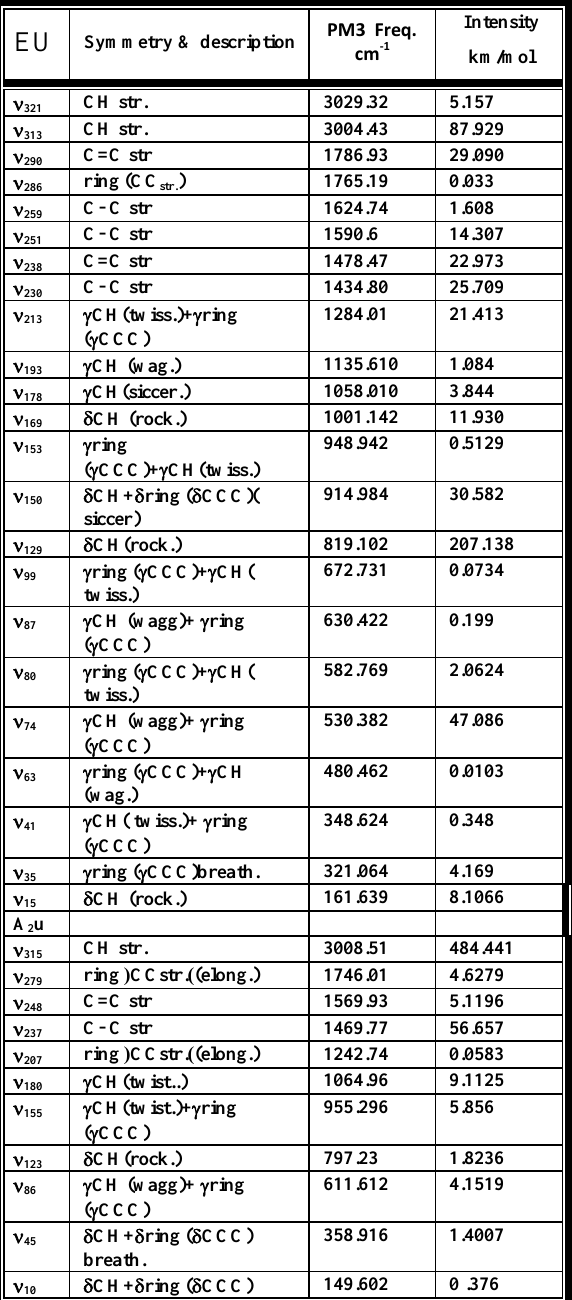
Table 4: Vibration frequencies and IR absorption intensities for (di-rings layer (C calculated applying G03 program by PM3